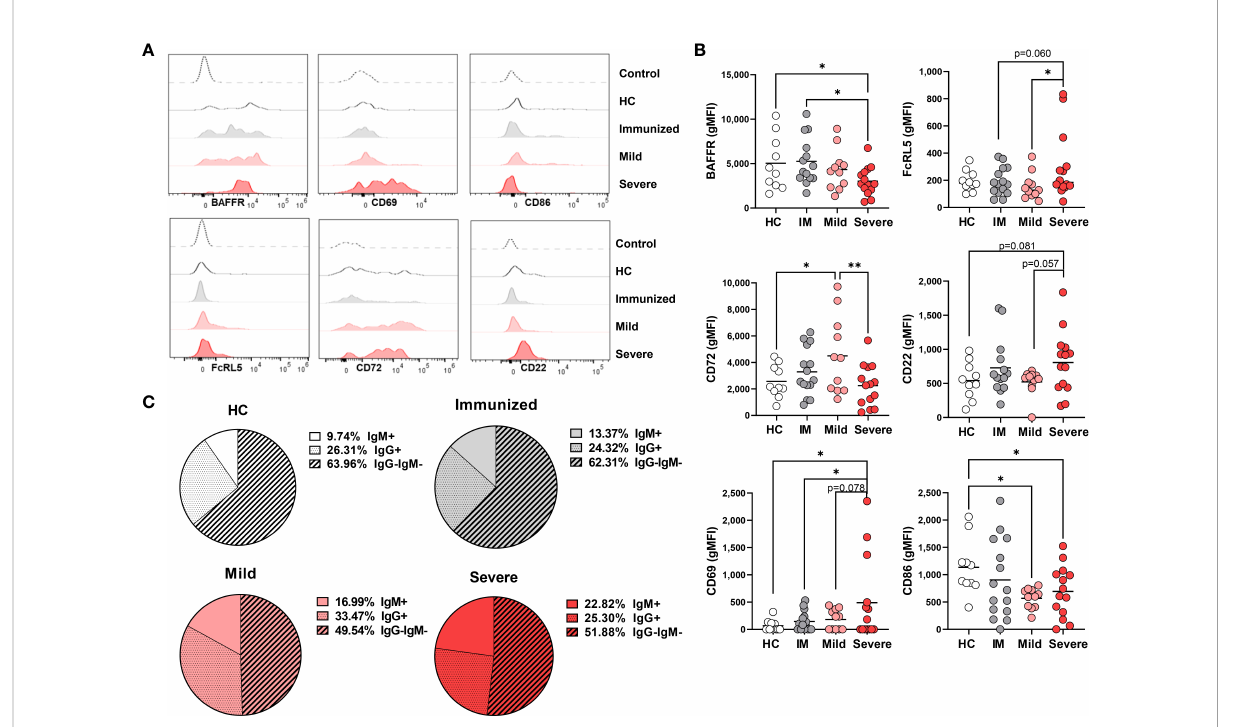
FIGURE 5 Phenotypic changes in DN3 cells with Severe SARS-CoV-2 infection. (A) Representative histograms depicting expression of BAFFR, CD69, CD86, FcRL5, CD72, and CD22 on DN3 cells from a healthy control (HC), a subject immunized against SARS-CoV-2, or individuals with mild or severe SARS-CoV-2 infection. Control dotted histogram is an FMO for CD69, CD68, CD72 and CD22. Control dotted histogram for BAFFR and FcRL5 is expression on CD3+ T cells from a healthy control subject. (B) Quanti fi cation of BAFFR, CD69, CD86, FcRL5, CD72, and CD22 expression (gMFI: geometric mean fl uorescent intensity) on DN3 cells from healthy controls (HC), individuals immunized against SARS-CoV-2 (IM), or individuals with mild or severe SARS-CoV-2 infection. (C) Pie charts depicting the average frequency of IgM+, IgG+, or IgG-IgM- DN3 cells for healthy controls (HC, N=10), individuals immunized against SARS-CoV-2 (N=15), and individuals with mild (N=11) or severe SARS-CoV-2 infection (N=14). Statistics: one-way ANOVA, *p < 0.05, **p <